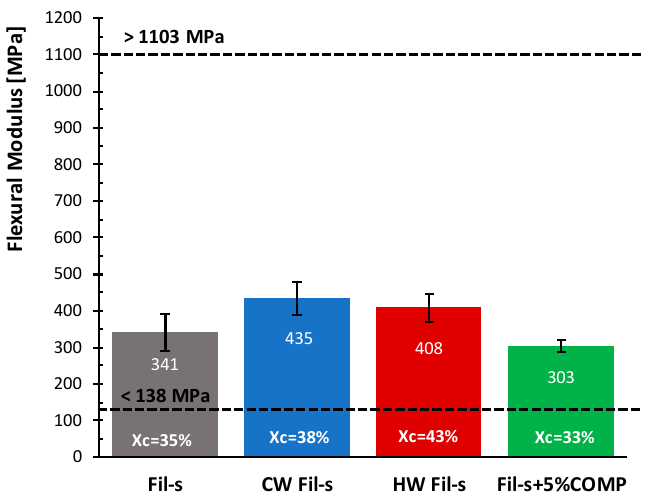
Figure 9. Comparison of the flexural moduli for the analysed Fil-s based systems. The data relative to the first and last “Flexural Modulus class”, as defined in ASTM D3350 standard, are also reported.